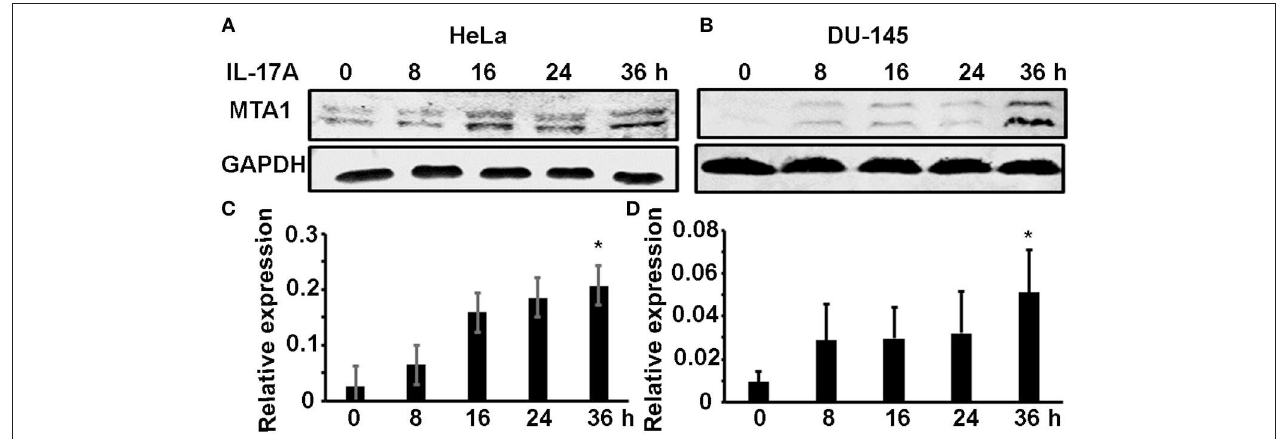
FIGURE 1 | IL-17A induces MTA1 protein expression in human cancer cells. HeLa and DU-145 cells were treated with 20ng/ml recombinant human IL-17A for the indicated time points. (A,B) Representative Western blot analysis of MTA1 protein expression, using GAPDH levels as loading controls. (C,D) Relative expression of MTA1 normalized by GAPDH levels; data represent mean ± standard deviation (SD, error bars) of 3 independent experiments; * p < 0.05 between the IL-17A-treated group and the time zero (untreated control) group.